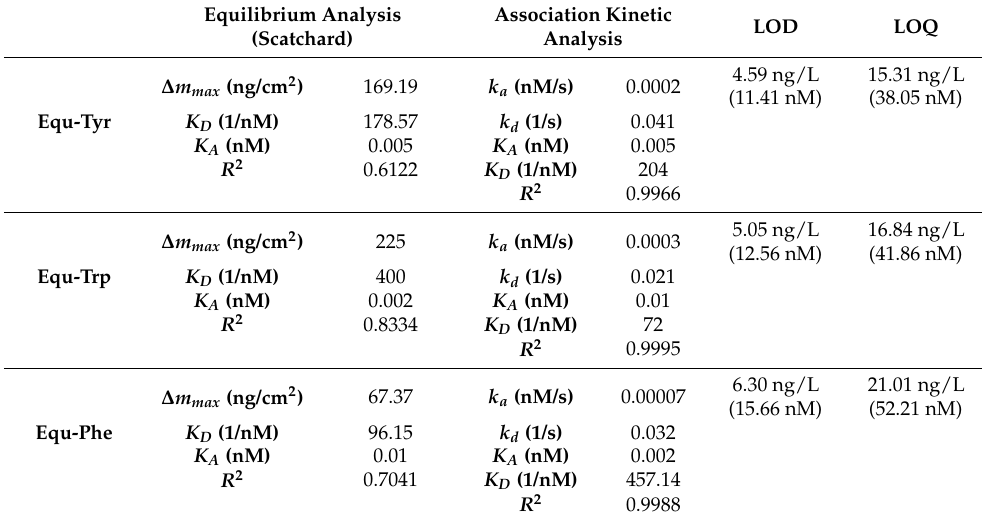
Table 4. Association kinetic analysis, LOD and LOQ values of Equ with three different amino acids. Equilibrium Analysis